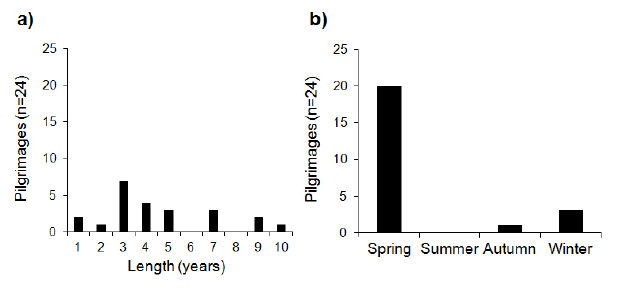
Fig. 3 . Devotion to the Virgin of Montserrat and location of the sanctuary. Villages of devotees were located within the Barcelona vegueria (in gray) and in other territories of Catalonia. Sources: devotion is represented by villages performing collective pilgrimages during or before the seventeenth century, as cited by Albareda (2010) and Verdés (2007).